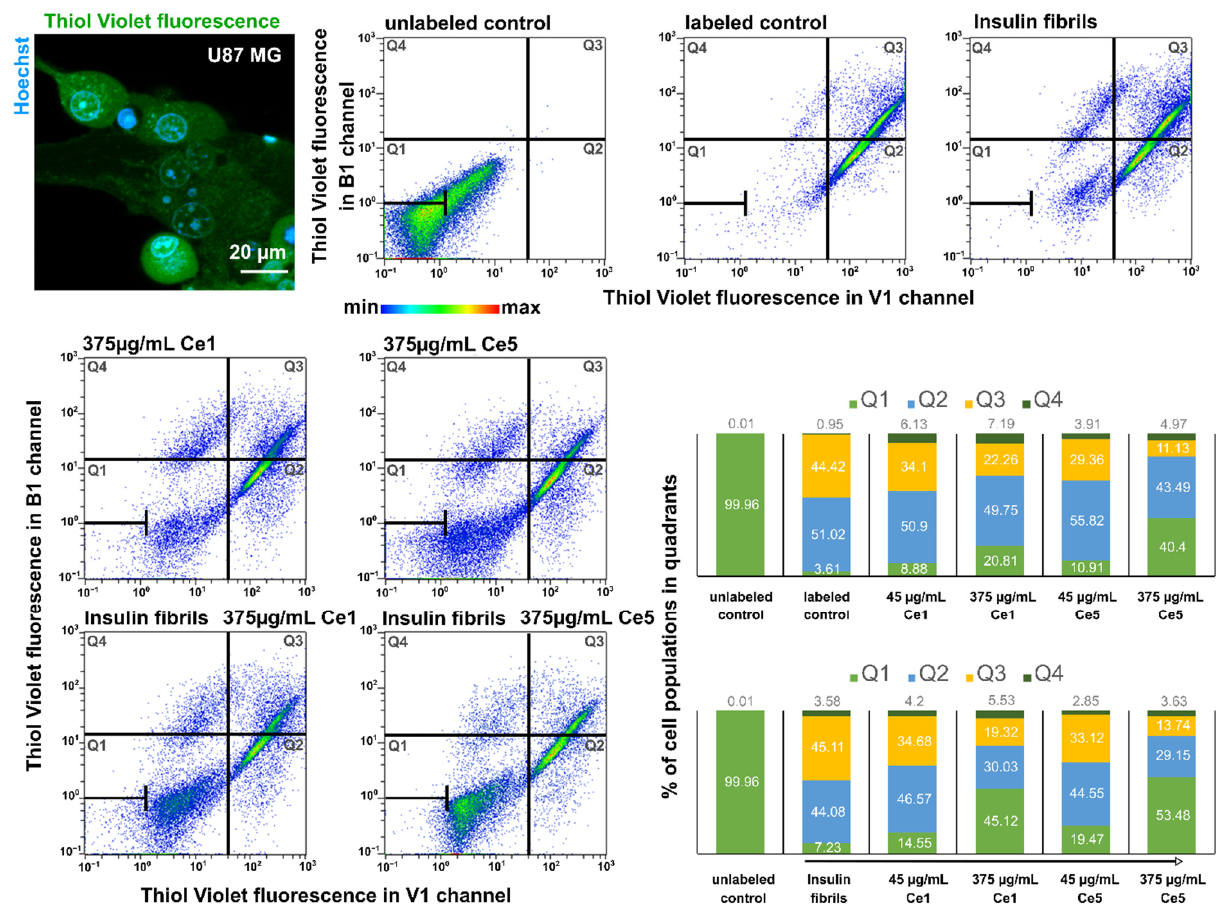
Figure 9. Reduced glutathione (GSH) levels in cells were monitored with ThiolTracker Violet fluorescence via flow cytometry. An illustrative fluorescence image of ThiolTracker Violet distribution in U87 MG cells is presented in the upper left panel. The cells were subjected to 5 μ M insulin fibrils, and Ce1 and Ce5 nanoparticles at concentrations of 45 and 375 μ g/mL. Cell populations in dot plots were divided into 4 quadrants (Q1–Q4). The numbers of cells and events are color-coded (blue—minima; red—maxima). Unlabeled cells were localized in Q1 (green histograms). Labeled untreated cell populations were identified in Q2 (blue histograms) and Q3 (yellow histograms). The quantification of cell populations is summarized in histograms (lower histograms—cells treated with insulin fibrils).